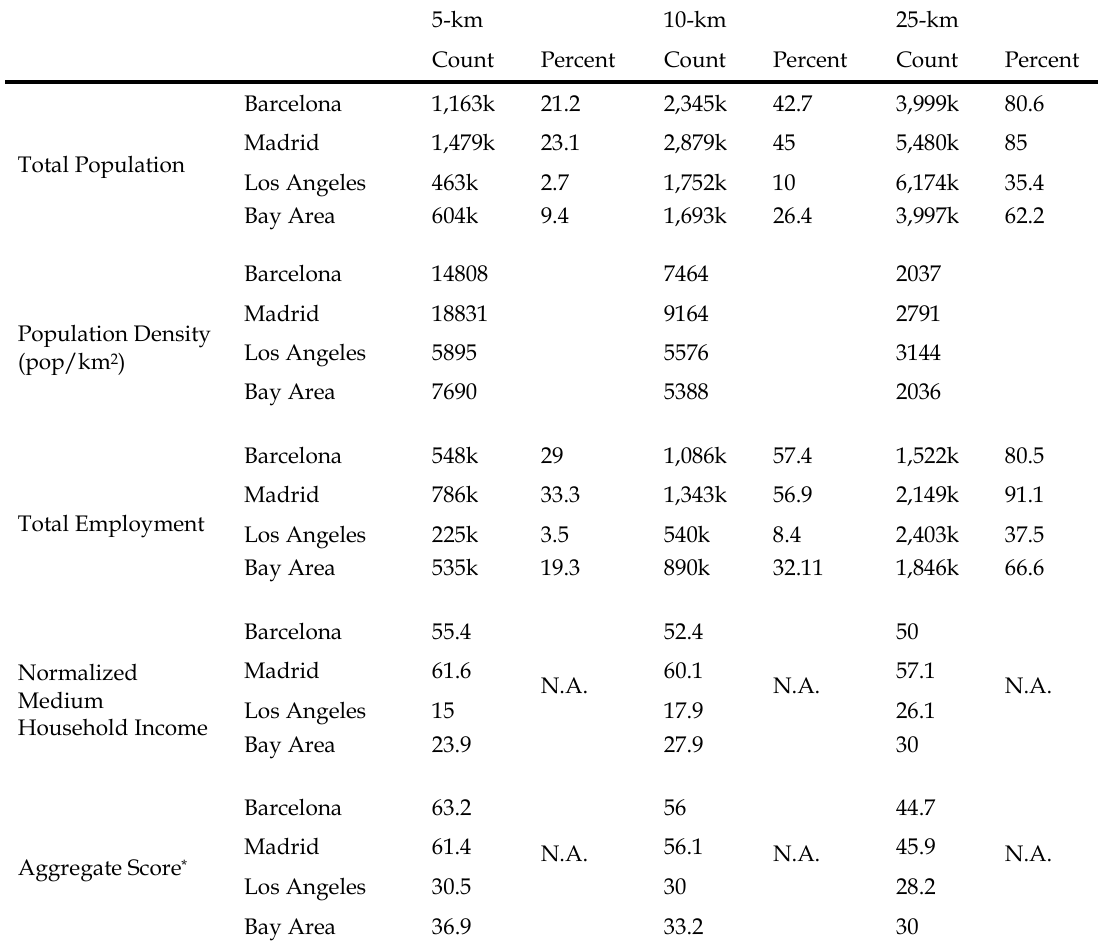
Table 3. Population, Employment, Income and Aggregate Scores by HSR Catchment Areas 5-km 10-km 25-km Count Percent Count Percent Count